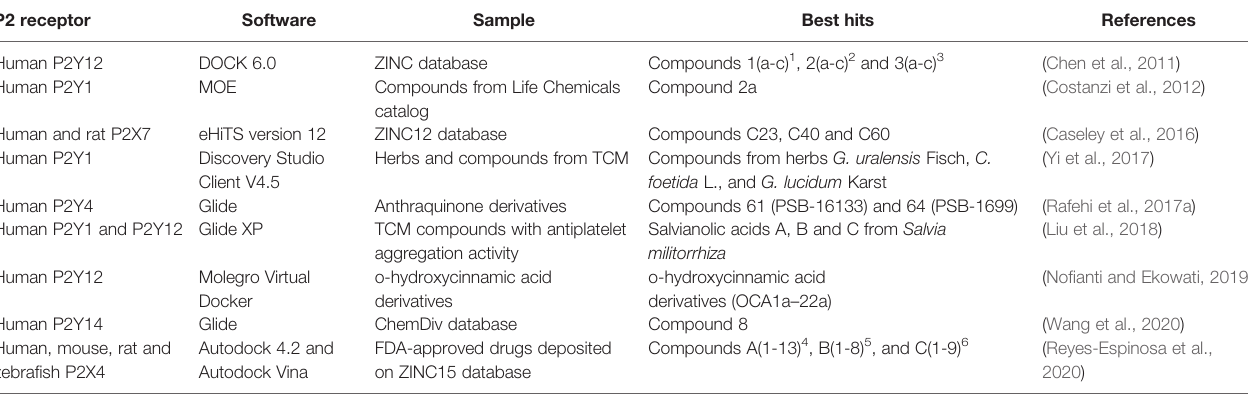
TABLE 2 | Virtual screening campaigns targeting P2 receptors by applying the molecular docking